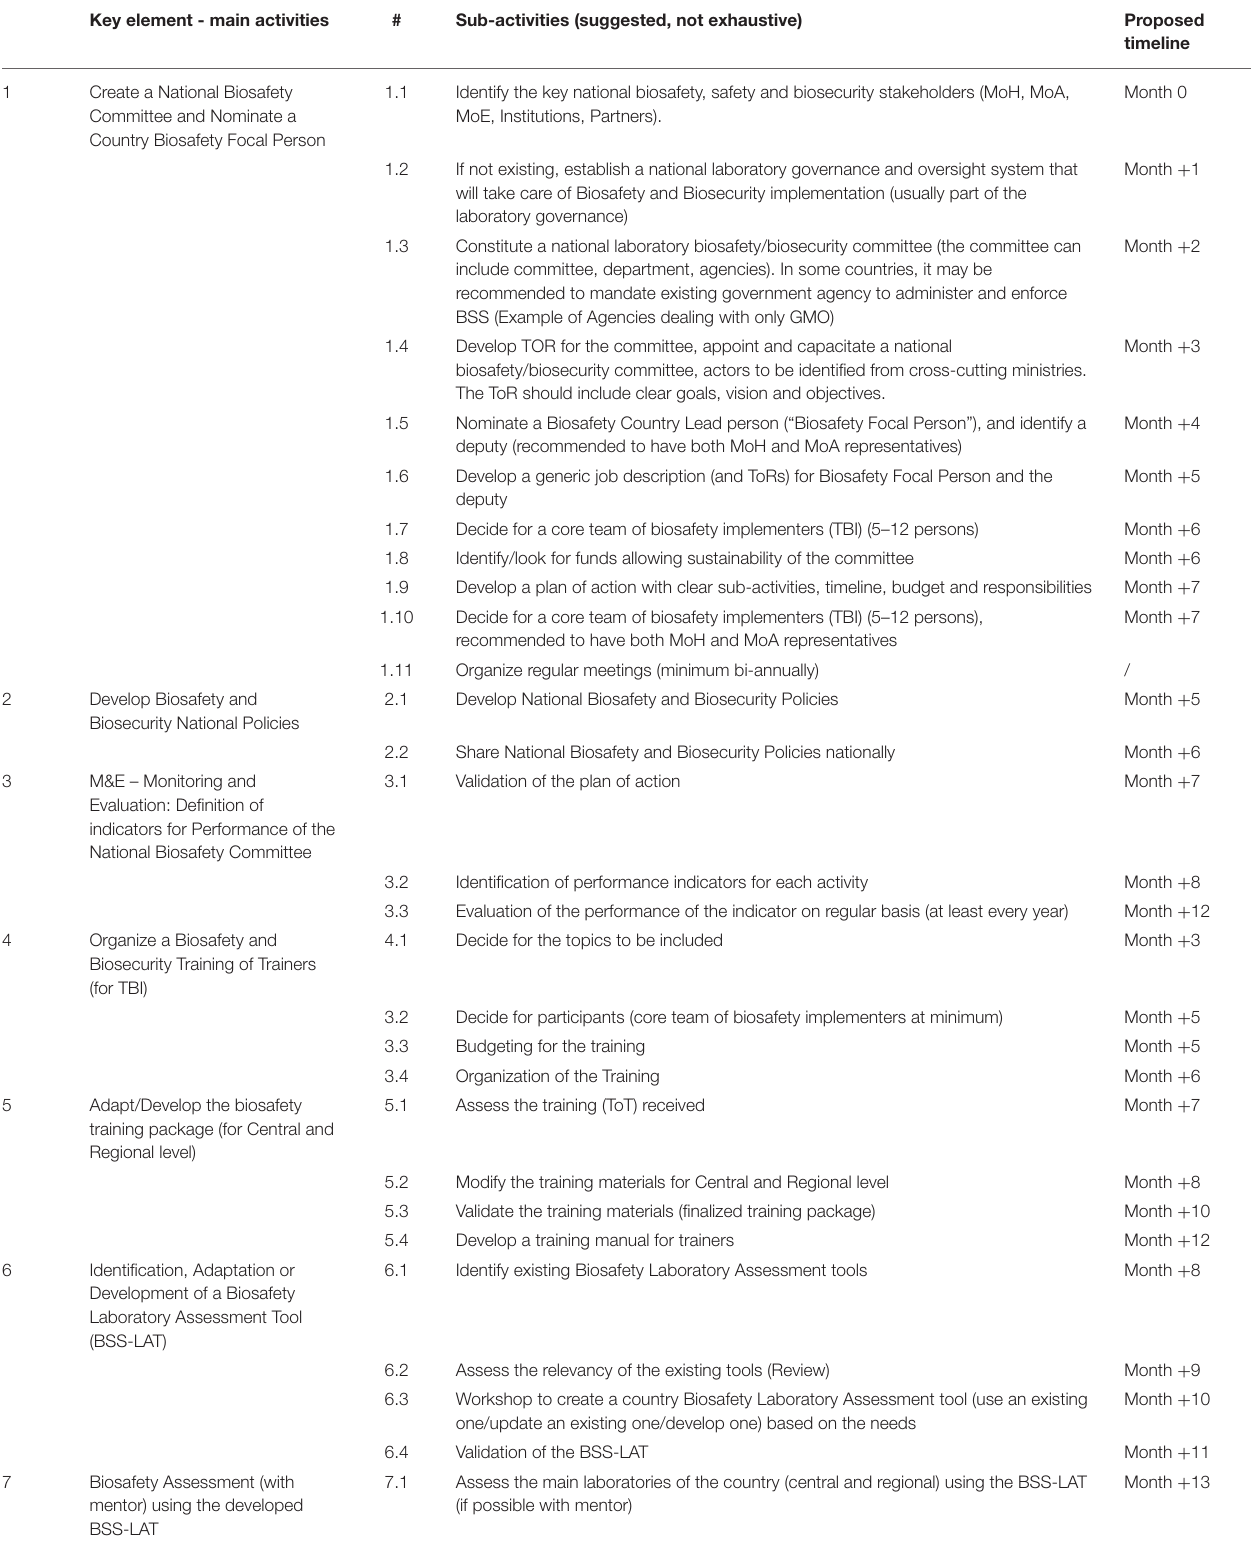
TABLE 1 | Proposed combined framework approach based on 15 key elements, and detailed